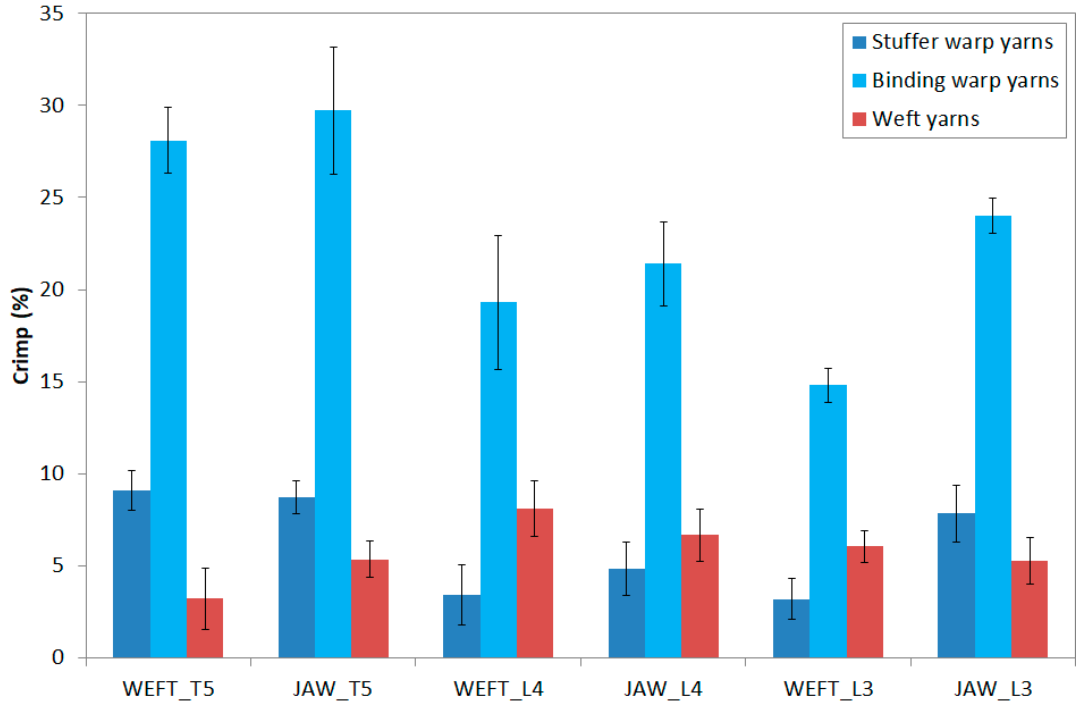
Figure 6. Measured crimp values of the different yarns for the six different 3D warp interlock fabrics. Thickness and areal density